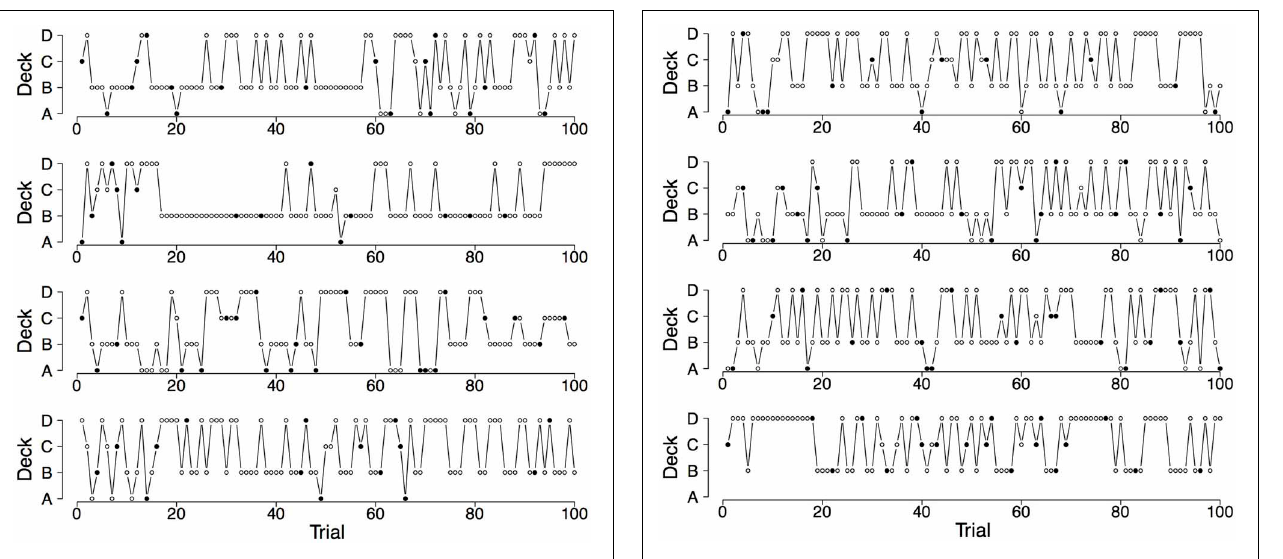
FIGURE 7 | Deck selection profiles of four synthetic participants showing a pronounced preference for the decks with infrequent losses (generated by the PVL-Delta model; A = 0 . 00, w = 0 . 00, a = 0 . 42, c = 1 .